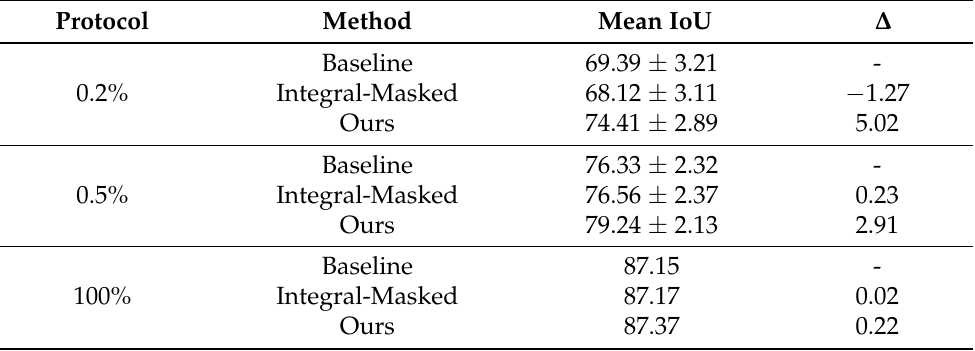
Table 4. Performance comparison between masking patches from the central area and masking patches from the whole area of the image during self-supervised pretraining in terms of mIoU on the LaPa test set. ∆ denotes the mIoU gain based on the baseline. Integral-Masked denotes masking patches from the whole area of the image.